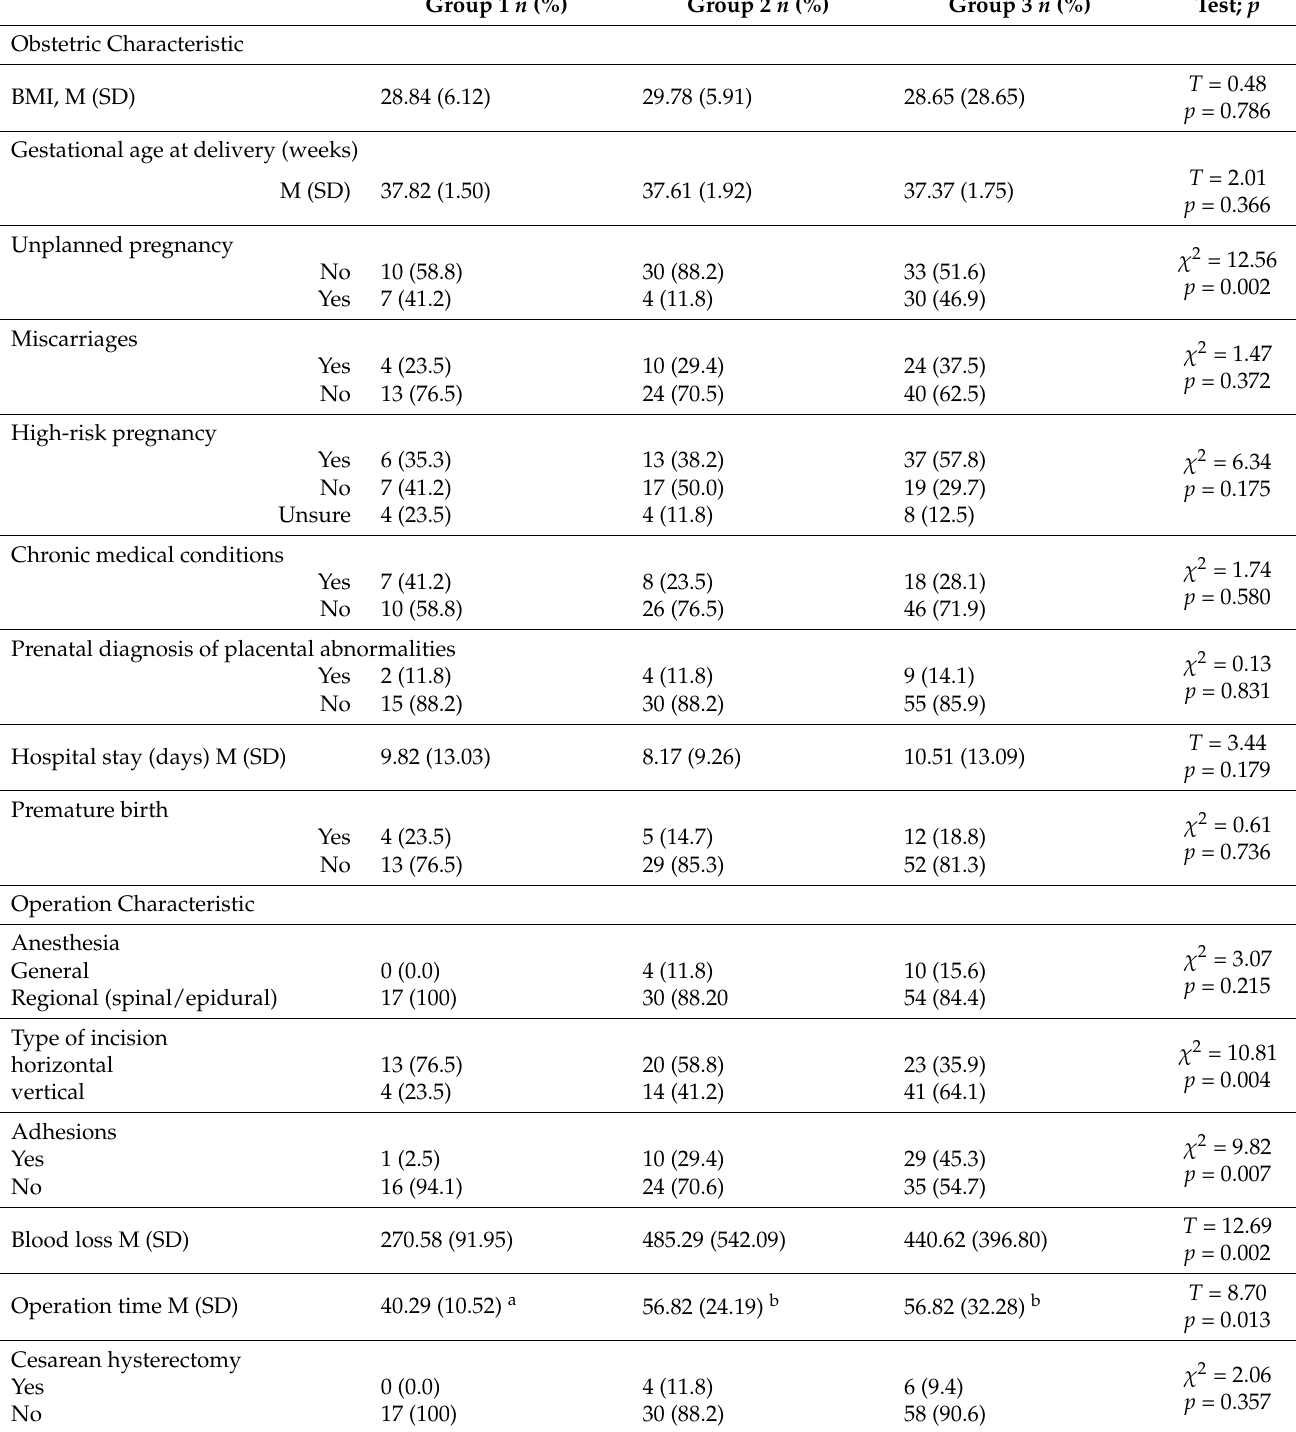
Table 2. Obstetric, anesthetic, and operational characteristics of all groups ( n =